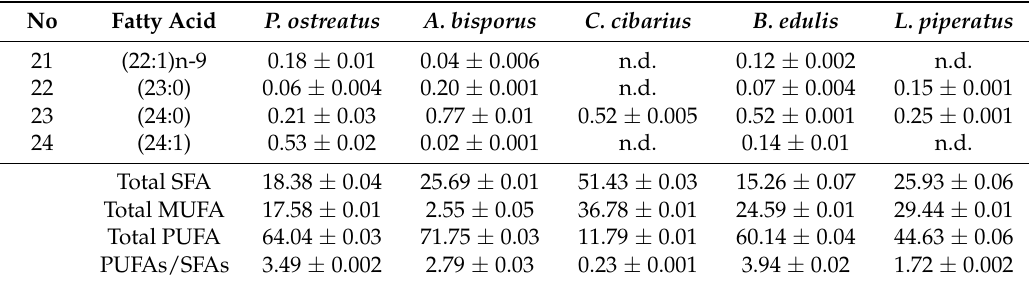
P. ostreatus—Pleurotus ostreatus, A. bisporus—Agaricus bisporus, C. cibarius—Cantharellus cibarius,